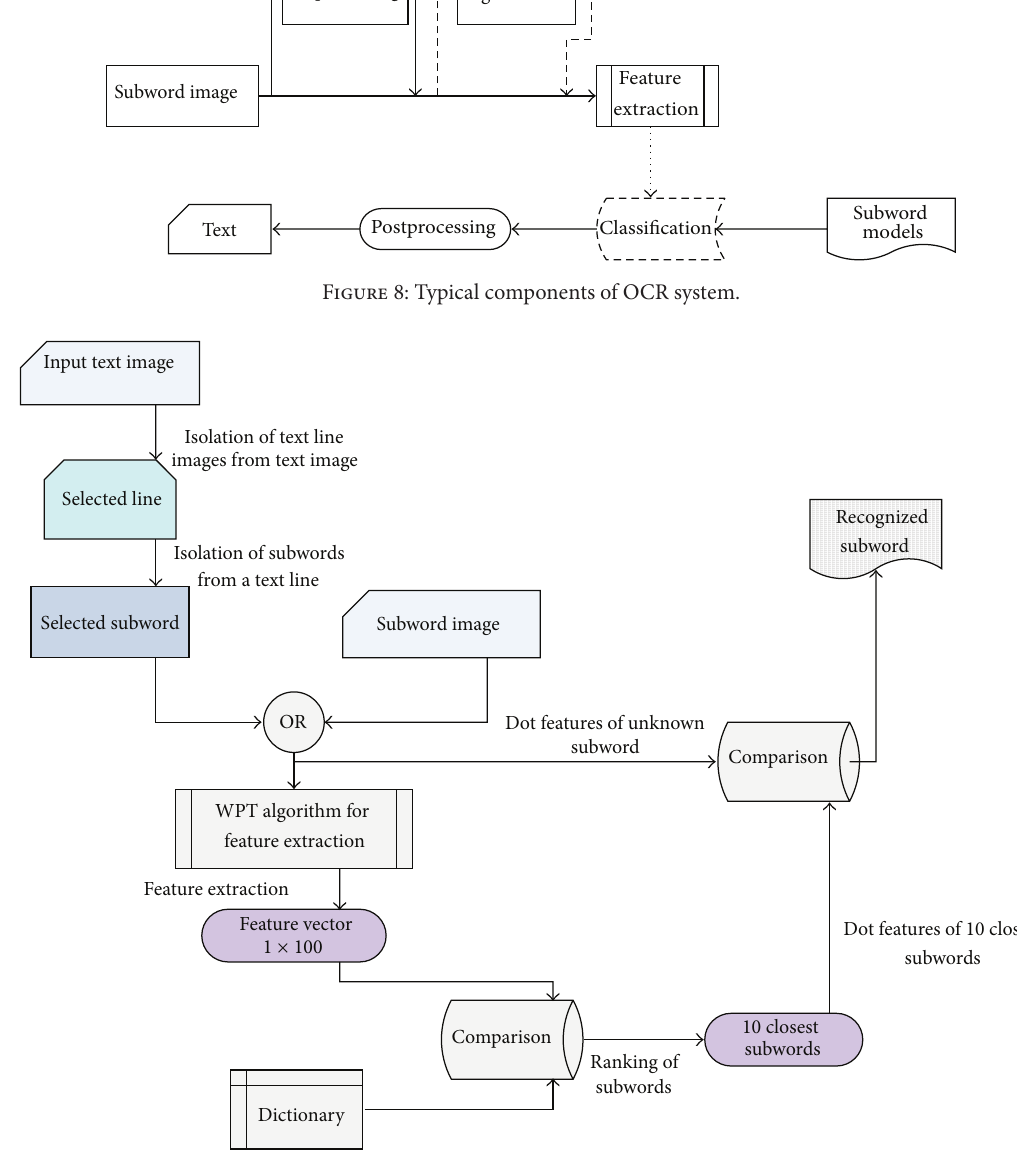
Figure 9: Block diagram of the proposed algorithm.